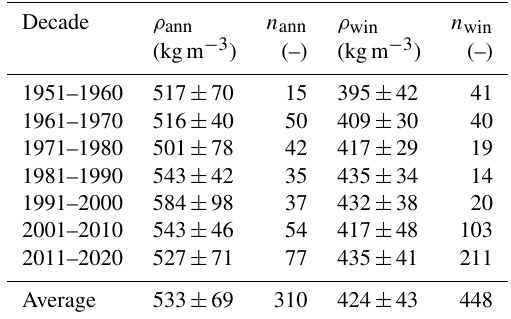
Table 2. Decadal averages of observed snow densities both at the annual scale ρ ann and for the winter period ρ win between 1951 and 2020. n is the number of documented direct measurements in the respective interval. The standard deviation of all measurements per period is given. Before averaging, values for the winter period have been homogenized to correspond to 30 April based on the densifi- cation rate of Eq.